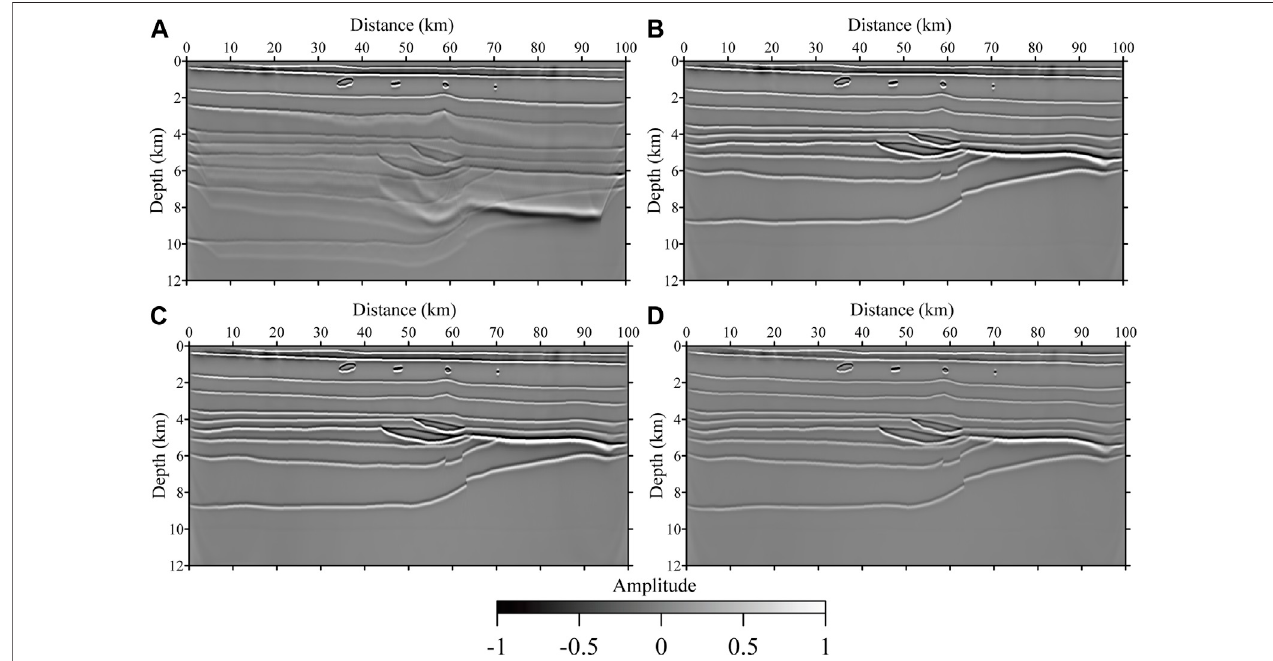
FIGURE 12 | Kirchhoff PSDM pro fi les: migration velocity shown in (A) Figure 8A , (B) Figure 9A , (C) Figure 10A , and (D) Figure 11A .